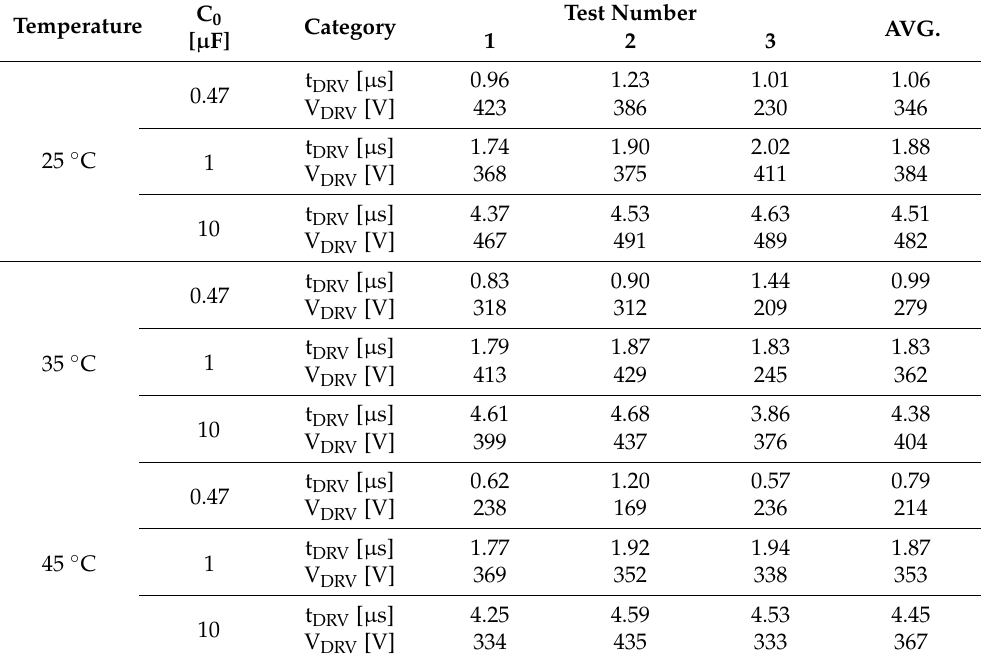
Table 3. Dielectric recovery voltage test results according to temperature.